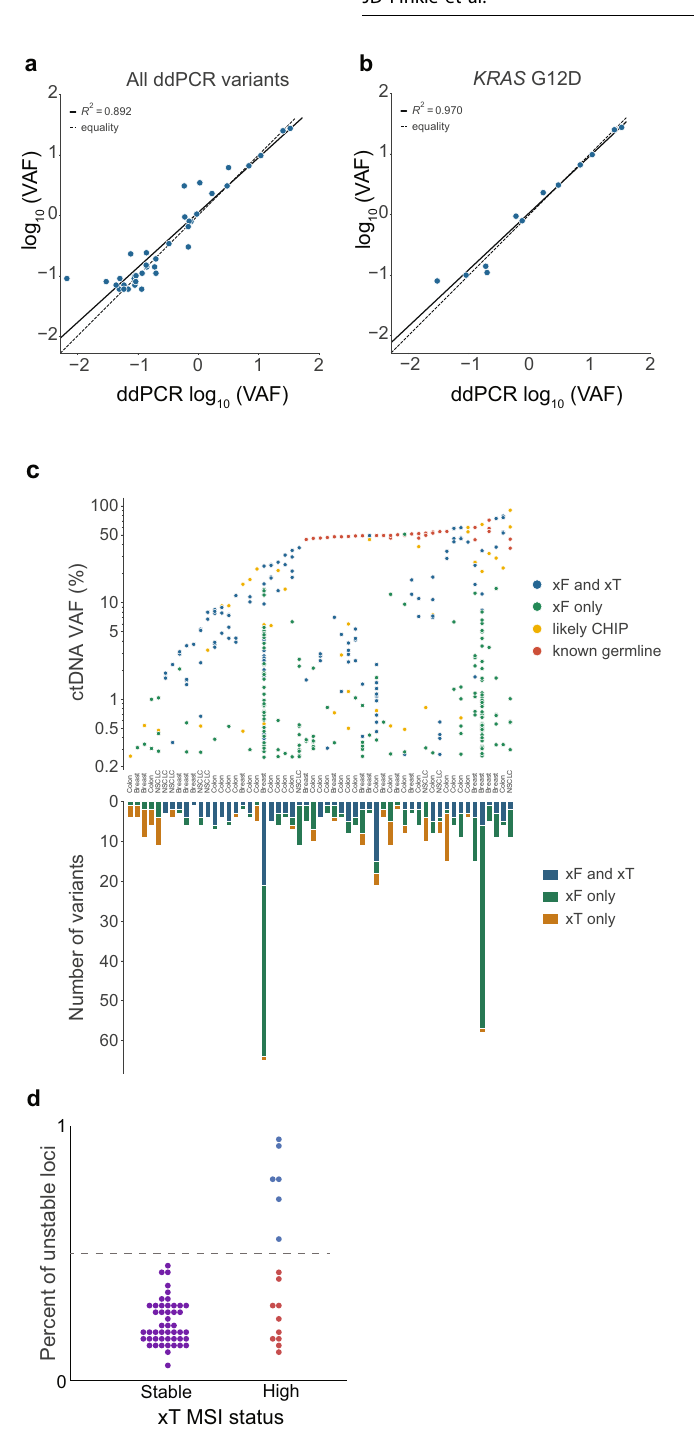
Fig. 1 Inter-assay comparison between Tempus xF, ddPCR, and Tempus xT results. Patient samples with selected variants ( n = 38) were analyzed by ddPCR and compared with xF variant allele fraction (VAF), resulting in high correlation overall (R 2 = 0.892) ( a ), and in individual variants such as KRAS G12D ( n = 12, R 2 = 0.970) ( b ). c Results from the Tempus xF liquid biopsy and xT solid tumor assays were compared in patients who received both tests ( n = 55) for colon, breast, and non-small cell lung cancers. The ctDNA VAFs for each variant are categorized by assay type in which they were detected and clonal hematopoiesis (CH) or germline status (top). The number of reportable variants for each individual patient are categorized by the assays in which they were detected (bottom). A total of 36 out of 55 xF samples had at least one pathogenic variant not detected in xT. d Among the 65 samples included in the microsatellite instability (MSI) validation cohort, 16 were deemed MSI-high and 49 microsatellite-stable. MSI was detected by xF in 6 out of 16 MSI-high patients, with 100% speci fi city (blue dots above dotted